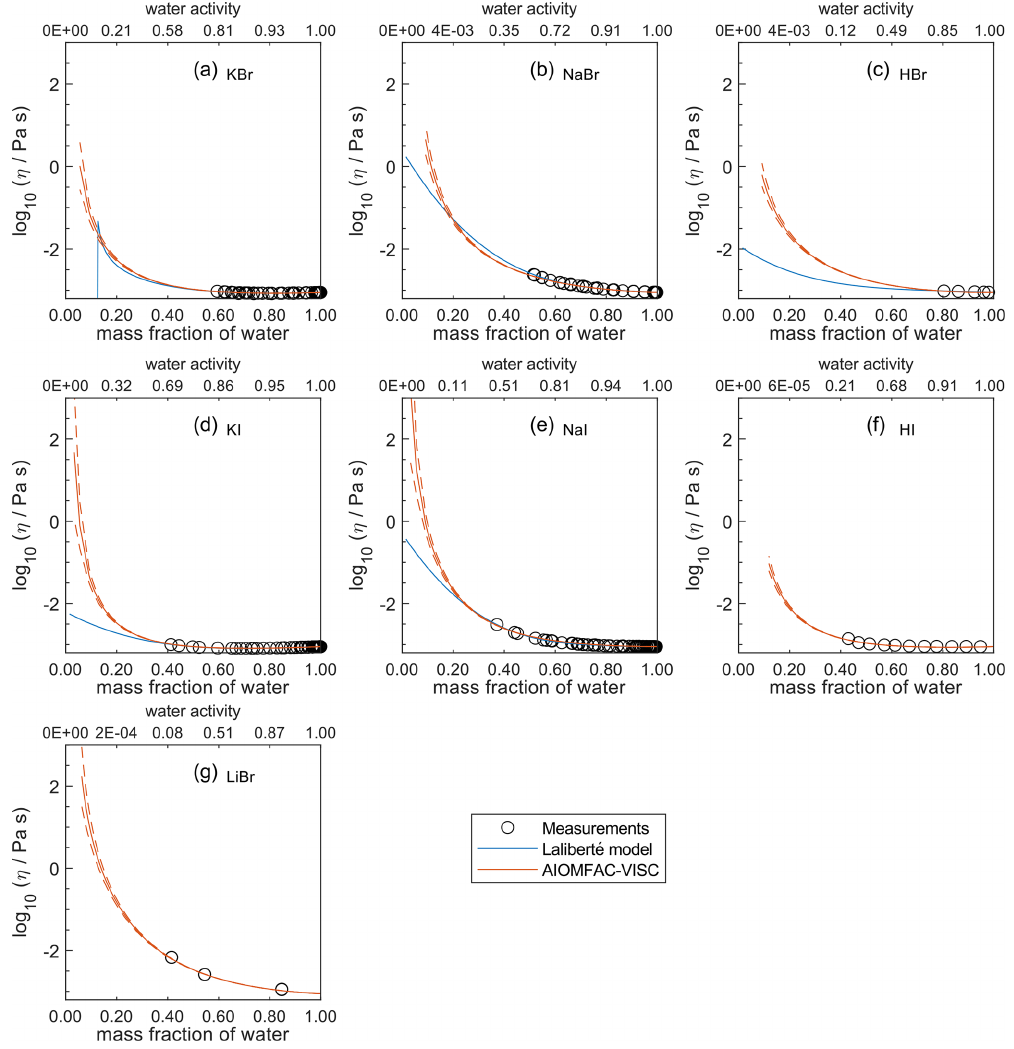
Figure 7. Comparison of the Laliberté model, AIOMFAC-VISC, and viscosity measurements versus mass fraction of water (bottom axis) and AIOMFAC-predicted water activity (top axis) for binary solutions of bromide and iodide salts at 298K with bulk measurements shown for 298 ± 1K: (a) KBr, (b) NaBr, (c) HBr, (d) KI, (e) NaI, (f) HI, and (g) LiBr. HI and LiBr were not fitted by the Laliberté model. See Fig. S9 for a zoomed-in version of this figure. See also caption to Fig.